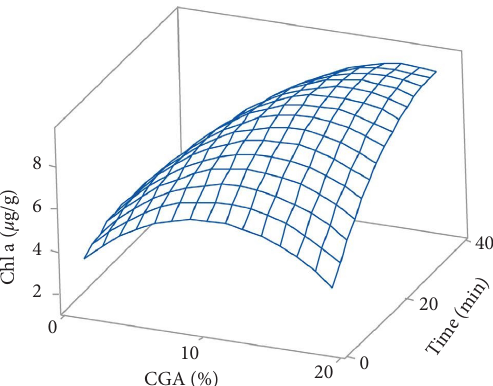
Figure 4: Response surface for chlorophyll a of coated tomatoes as function of Arabic gum concentration and time of treatment.